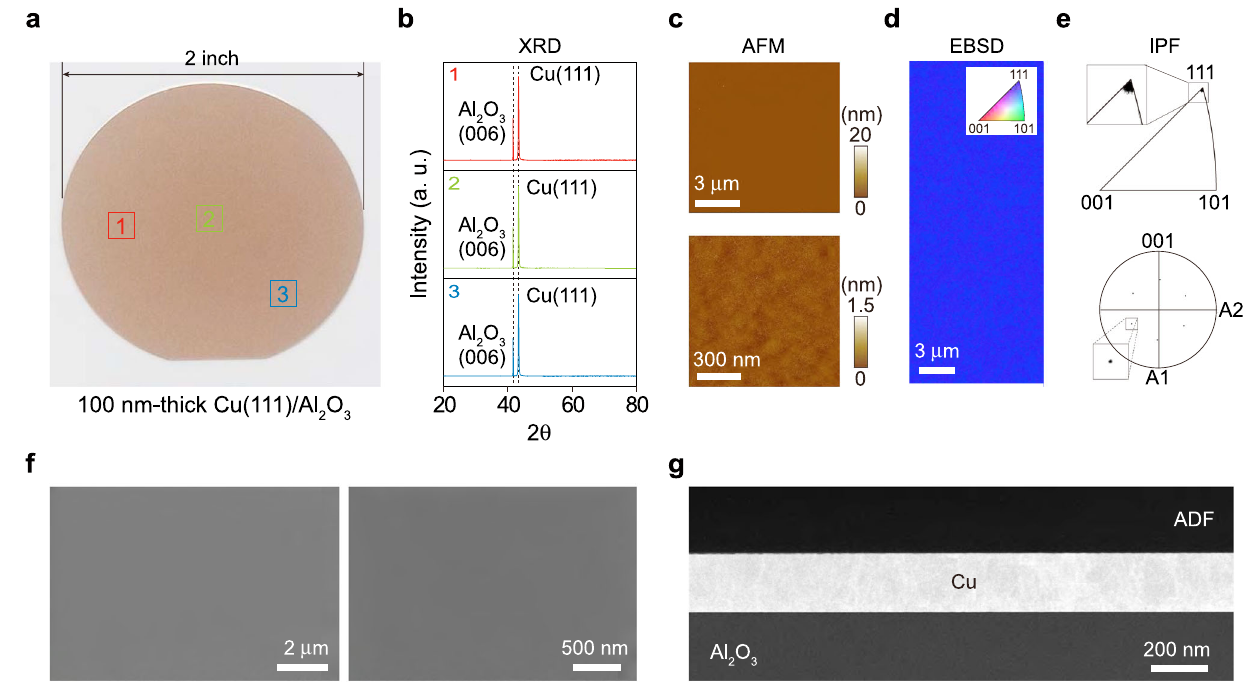
e Inverse pole fi gure(IPF) with a solespot associatedwith the (111) plane (top)and [100] pole fi gure (PF) showing the six-fold symmetry of the {100} (bottom). The inset images in e are magni fi ed images of the sole-spot areas. f Scanning electron microscopy images of the sample at different magni fi cations. g Low-magni fi cation the SCCF